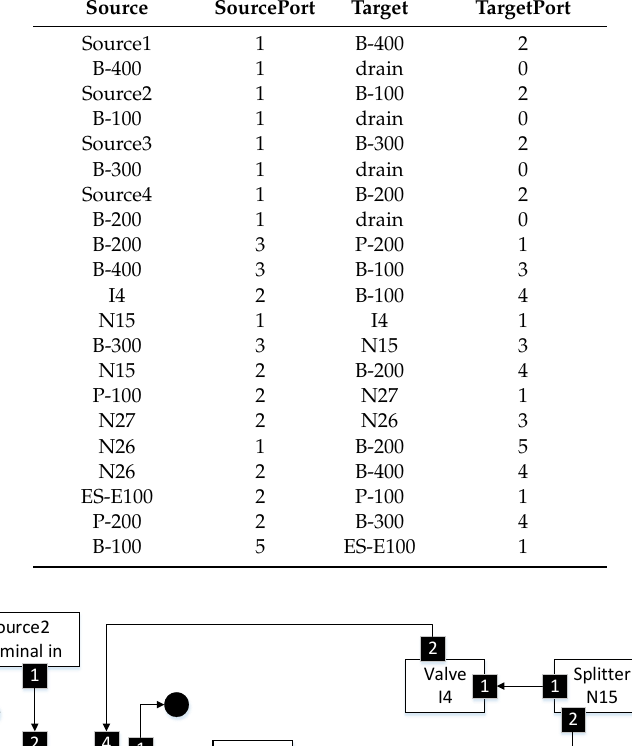
Table 3. Flows of the steady state model. The strings in ‘Source’ and ‘Target’ columns refer to symbol names in the ‘NodeName’ column of Table 2.